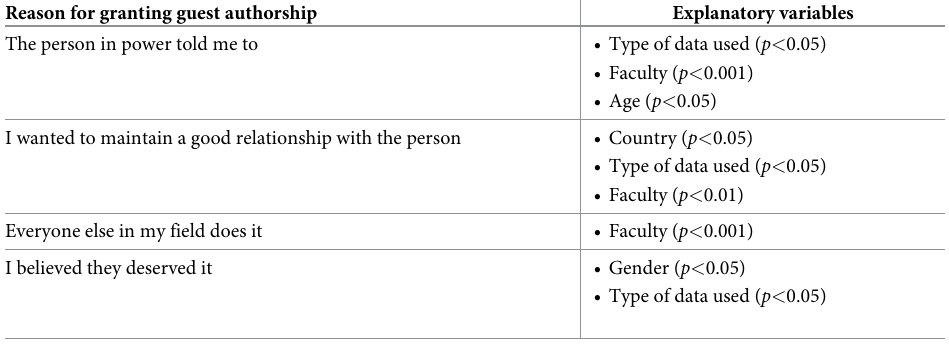
Table 9. Demographic and study-specific variables predictors of reason for granting guest authorship ( n =